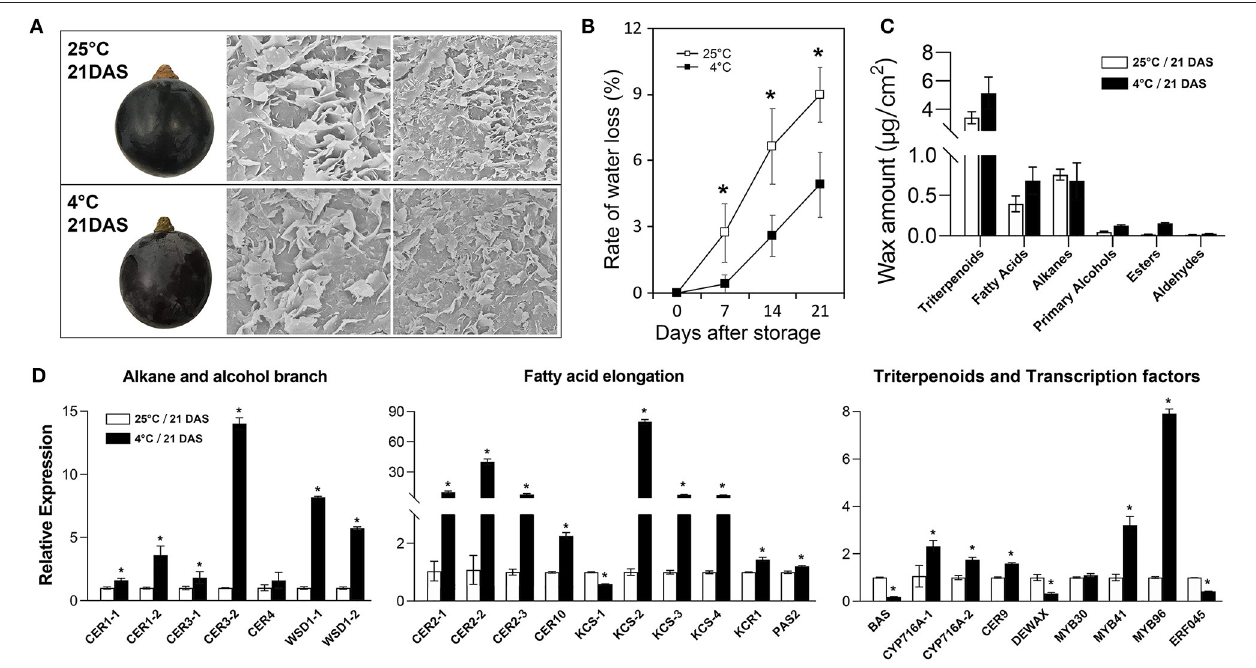
FIGURE 6 | Morphological, physiological, and molecular analysis of cuticular wax in grape berries during post-harvest storage. (A) berry morphology and microstructure of cuticular wax; (B) rate of water loss; (C) wax amount; (D) relative expression of wax-related genes. DAS, days after storage. Values are mean ± SD of three biological replicates. Significant differences at the P < 0.05 level were indicated by * according to Student’s t -test.